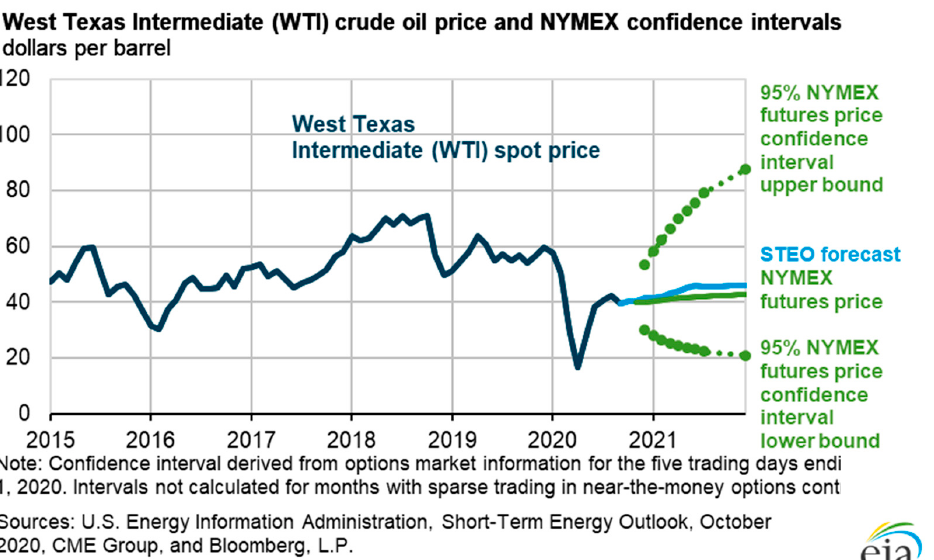
Figure 11. West Texas Intermediate price variation from August 2019 to early July 2020, Reproduced with permission from Oil Price [58].